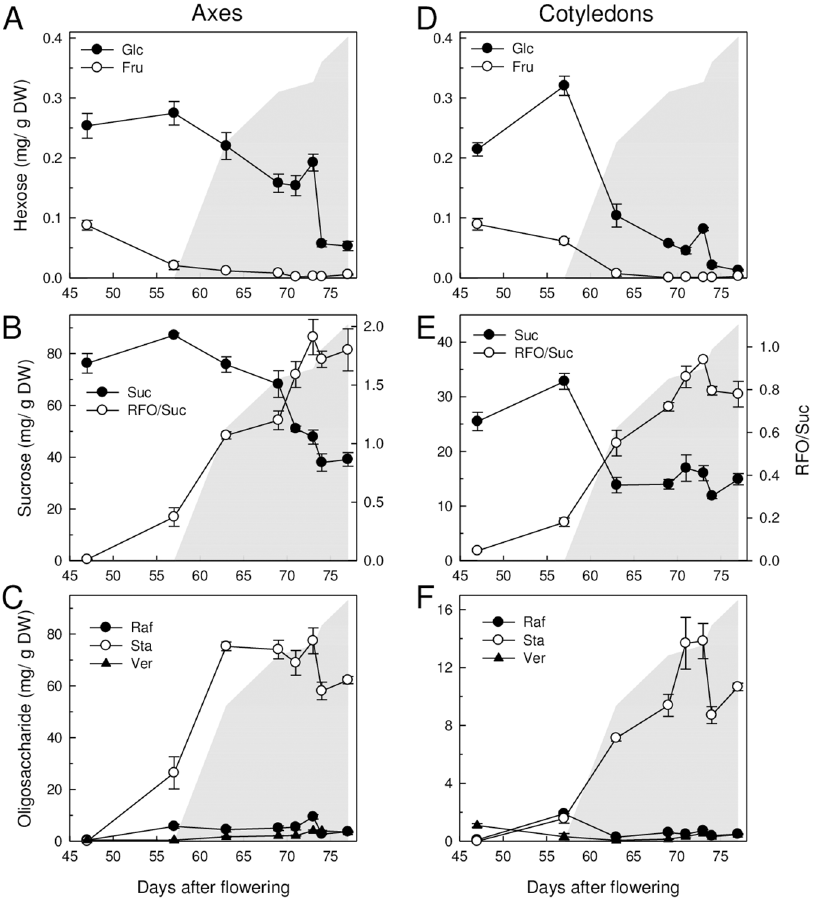
Fig 5. Changes in soluble sugar contents in axis and cotyledons during maturation. Data are the averageof triplicates ( ± SE) using 6 axis (A-C) and 6 cotyledonpairs (D-E) from the 2014 crop. The changes in RFO/Suc ratio are shown in panel B and E for axes and cotyledons,respectively. The increasein longevity (P50) is indicatedas a grey area as a help to the eye. (A, D) Glc, glucoseand Fru, fructose; (B, E) Suc, sucrose and RFO/Suc ratio; (C, F) Raf, Raffinose, Sta, Stachyose and Ver,